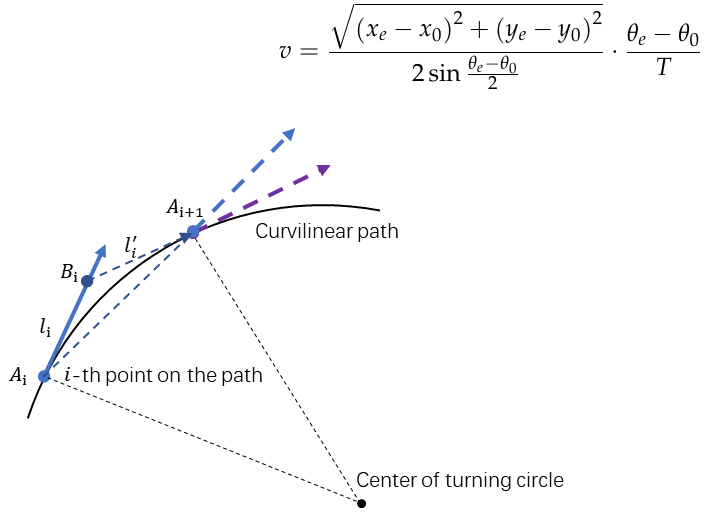
Figure 13. Illustration of geometric relations between two poses.